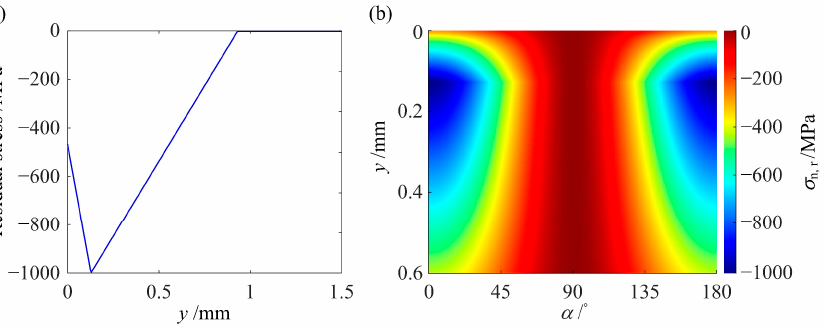
Figure 7. ( a ) A typical RS distribution profile and ( b ) the contour of σ n,r resulting from this RS distribution.